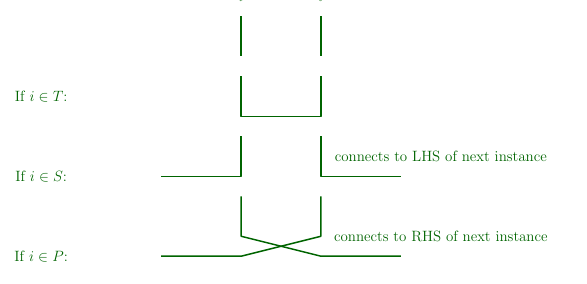
Figure 16 . Connecting the density matrix to its